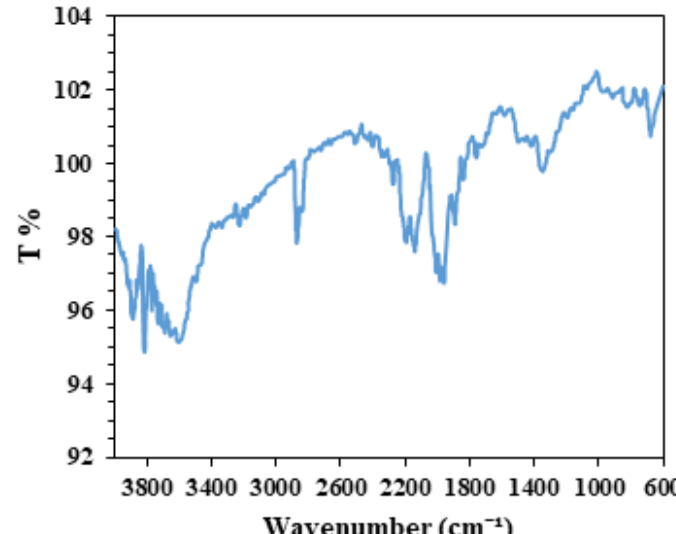
Figure 3: The FTIR analysis of biosynthesized AgNPs.